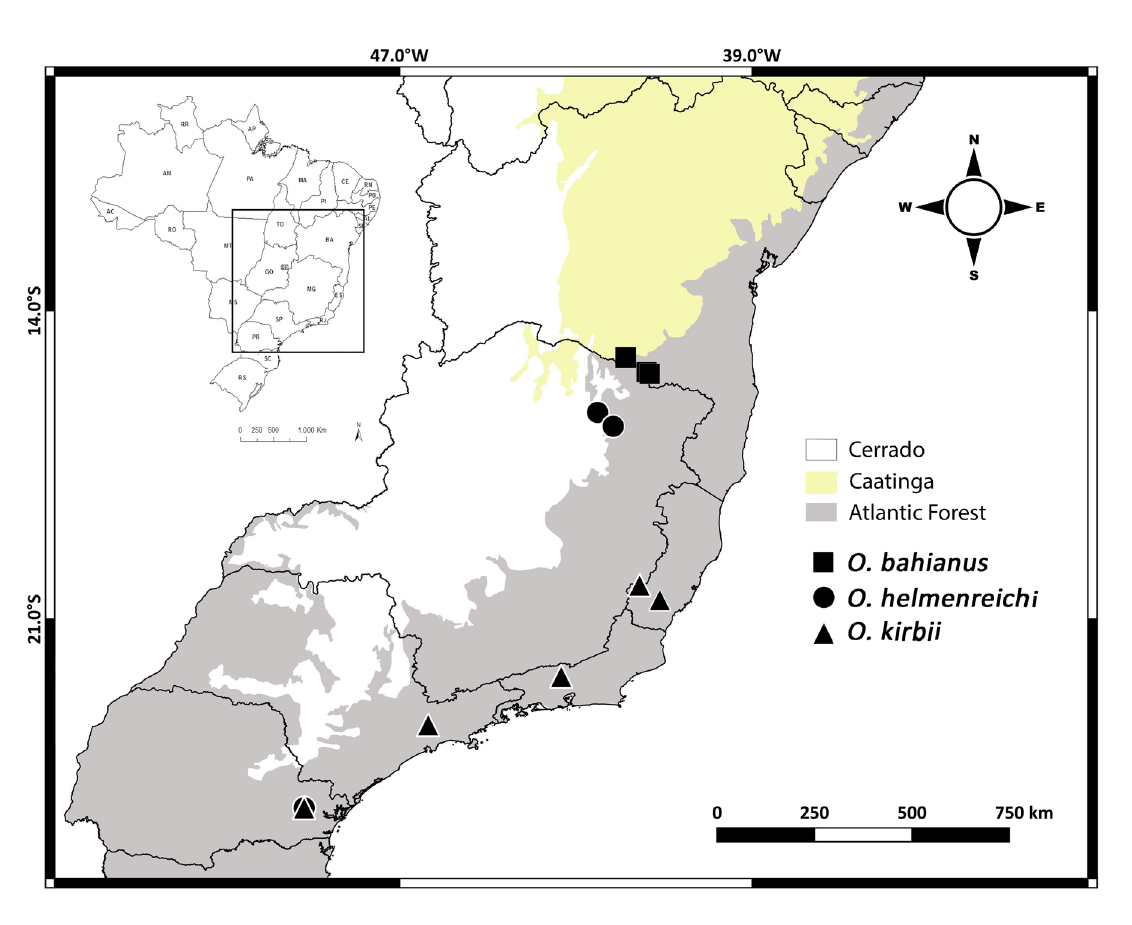
Fig. 9. Geographic distribution of Oplognathus MacLeay,